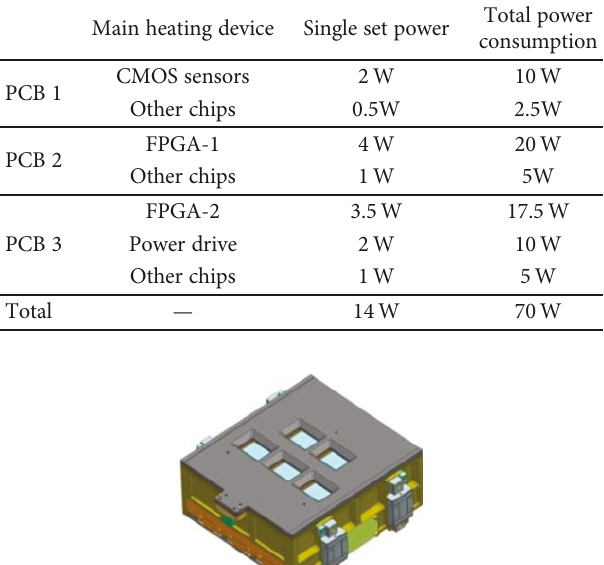
Table 1: Focal plane power consumption statistics.